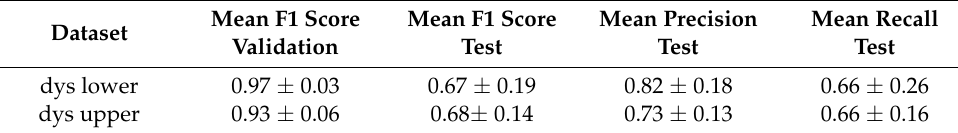
Table 5. Overview of mean F1 score, precision and